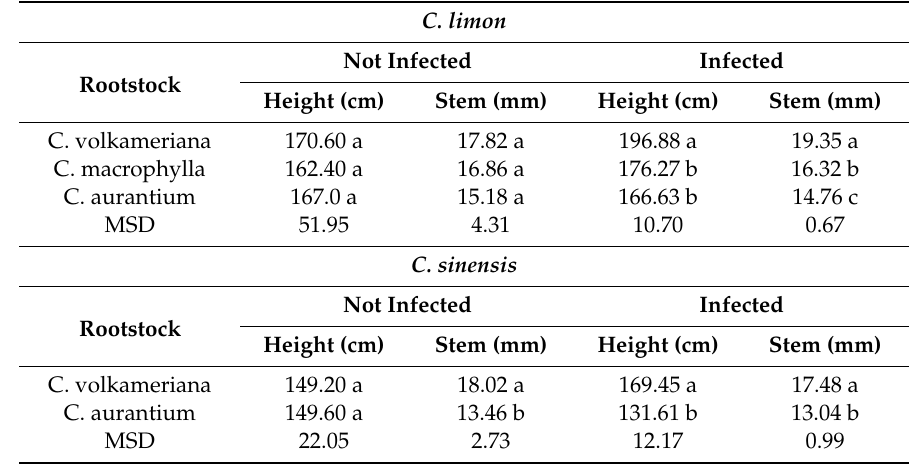
Table 4. Plant height and rootstock stem diameter of uninfected and infected C. limon and C. sinensis